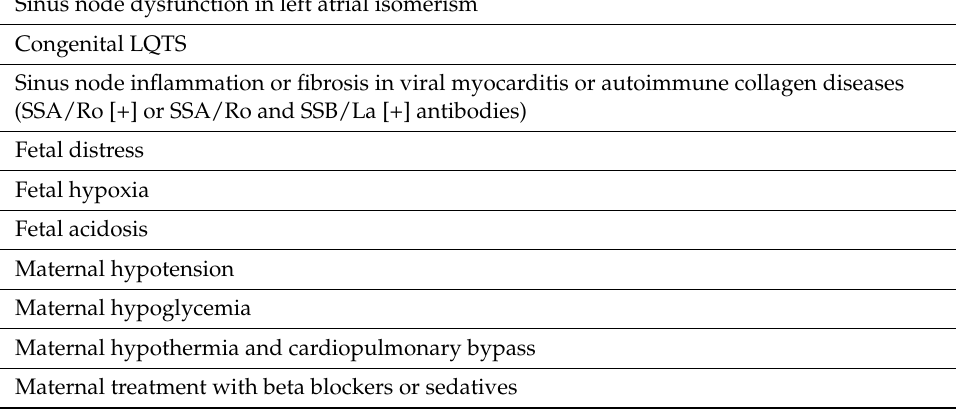
Table 2. Causes of sinus bradycardia. Sinus node dysfunction in left atrial